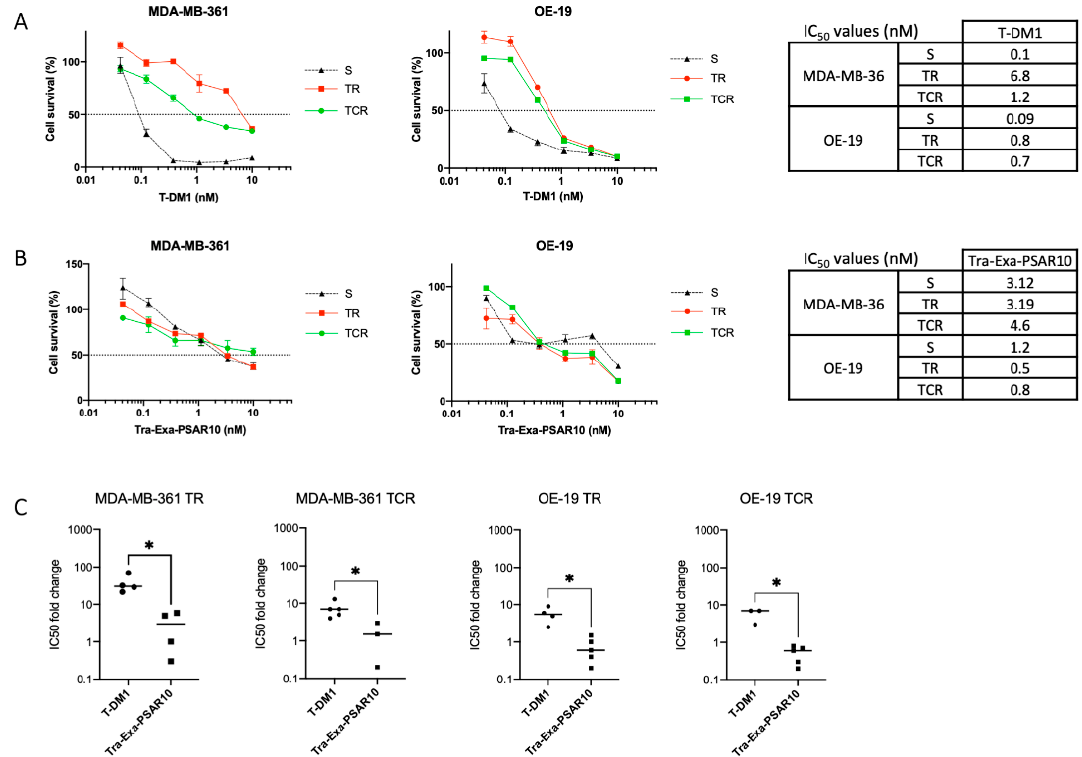
Figure 6. In vitro cytotoxicity of Tra-Exa-PSAR10 in cells resistant to T-DM1. ( A ) Cytotoxicity assay of T-DM1 in MDA-MB-361 and OE-19 sensitive (S) and T-DM1-resistant (TR and TCR) cells showing an increase in the IC 50 values of resistant cells compared to parental. ( B ) Exposure of cells resistant to T-DM1 to Tra-Exa-PSAR10 showing comparable cytotoxicity in parental and T-DM1 resistant cells. ( C ) Relative resistance of TR and TCR cell lines to T-DM1 or Tra-Exa-PSAR10 represented as the IC 50 of resistant cell line over the parental cell line for each experiment. *: p < 0,05. S: sensitive cells, TR: T-DM1 resistant cells and TCR: T-DM1 resistant cells generated in the presence of ciclosporin A.